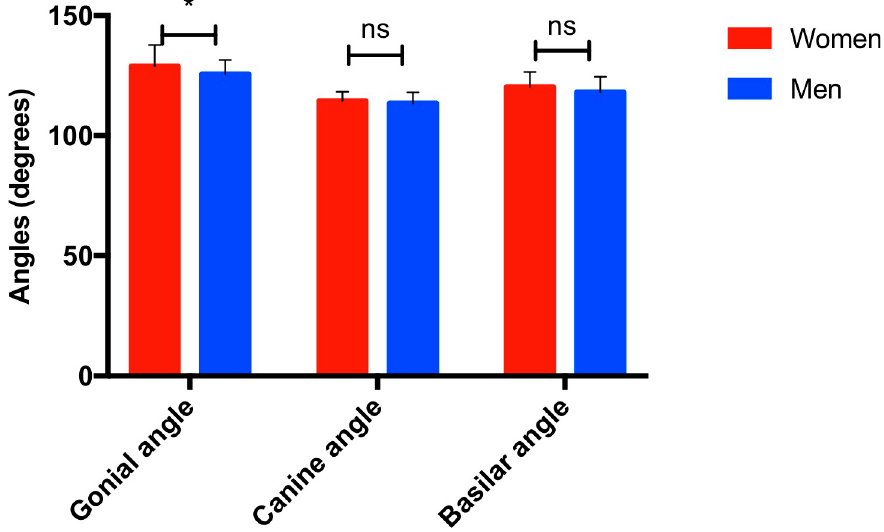
Fig 3. Histogram of the different angle measurements obtained illustrating sexual dimorphism. Gonial angle: women: 128,9˚ ± 8,9˚, men: 125,7˚ ± 5,9˚, p = 0,011. Canine angle: women: 114,6˚ ± 3,7˚, men: 113,6˚ ± 4,6˚, p = 0,74. Basilar angle: women: 120,3˚ ± 6,2˚, men: 118,2˚ ± 6,3˚, p = 0,16, n = 30 in each of the groups studied, ns: not statistically significant, � : p < 0,05.